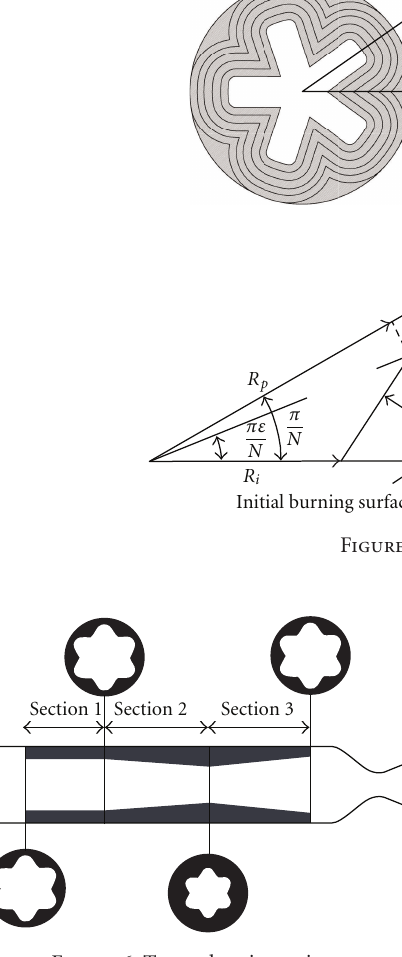
Figure 6: Tapered grain sections.